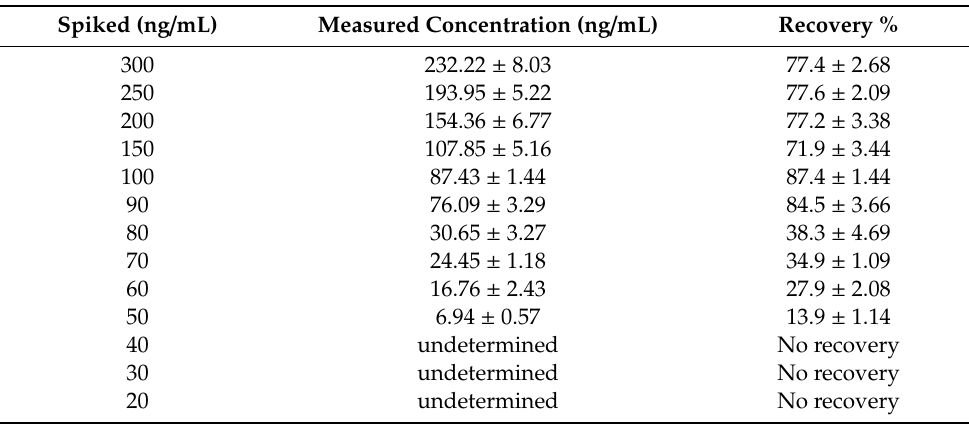
Table 3. Testing of salmon fillet sample spiked with